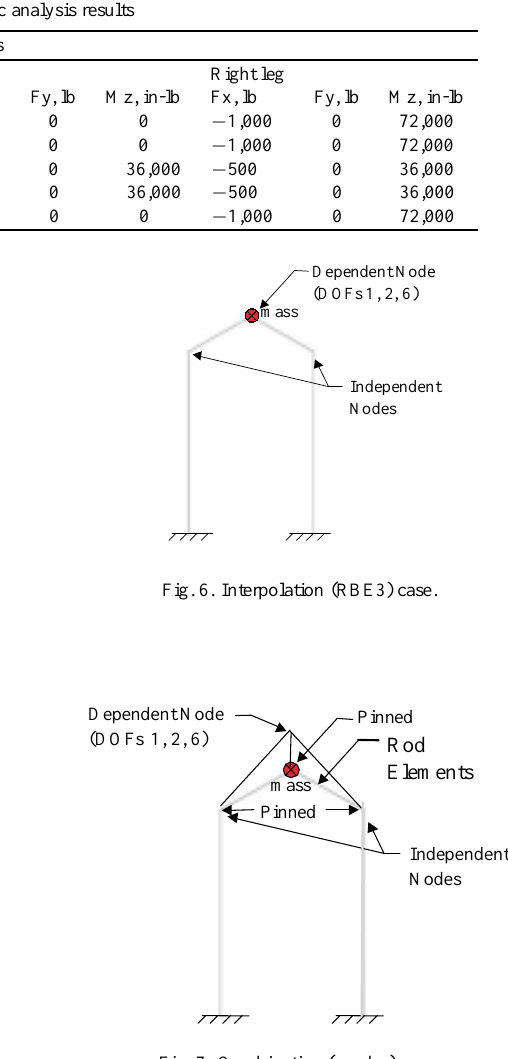
Fig. 7. Combination (combo)